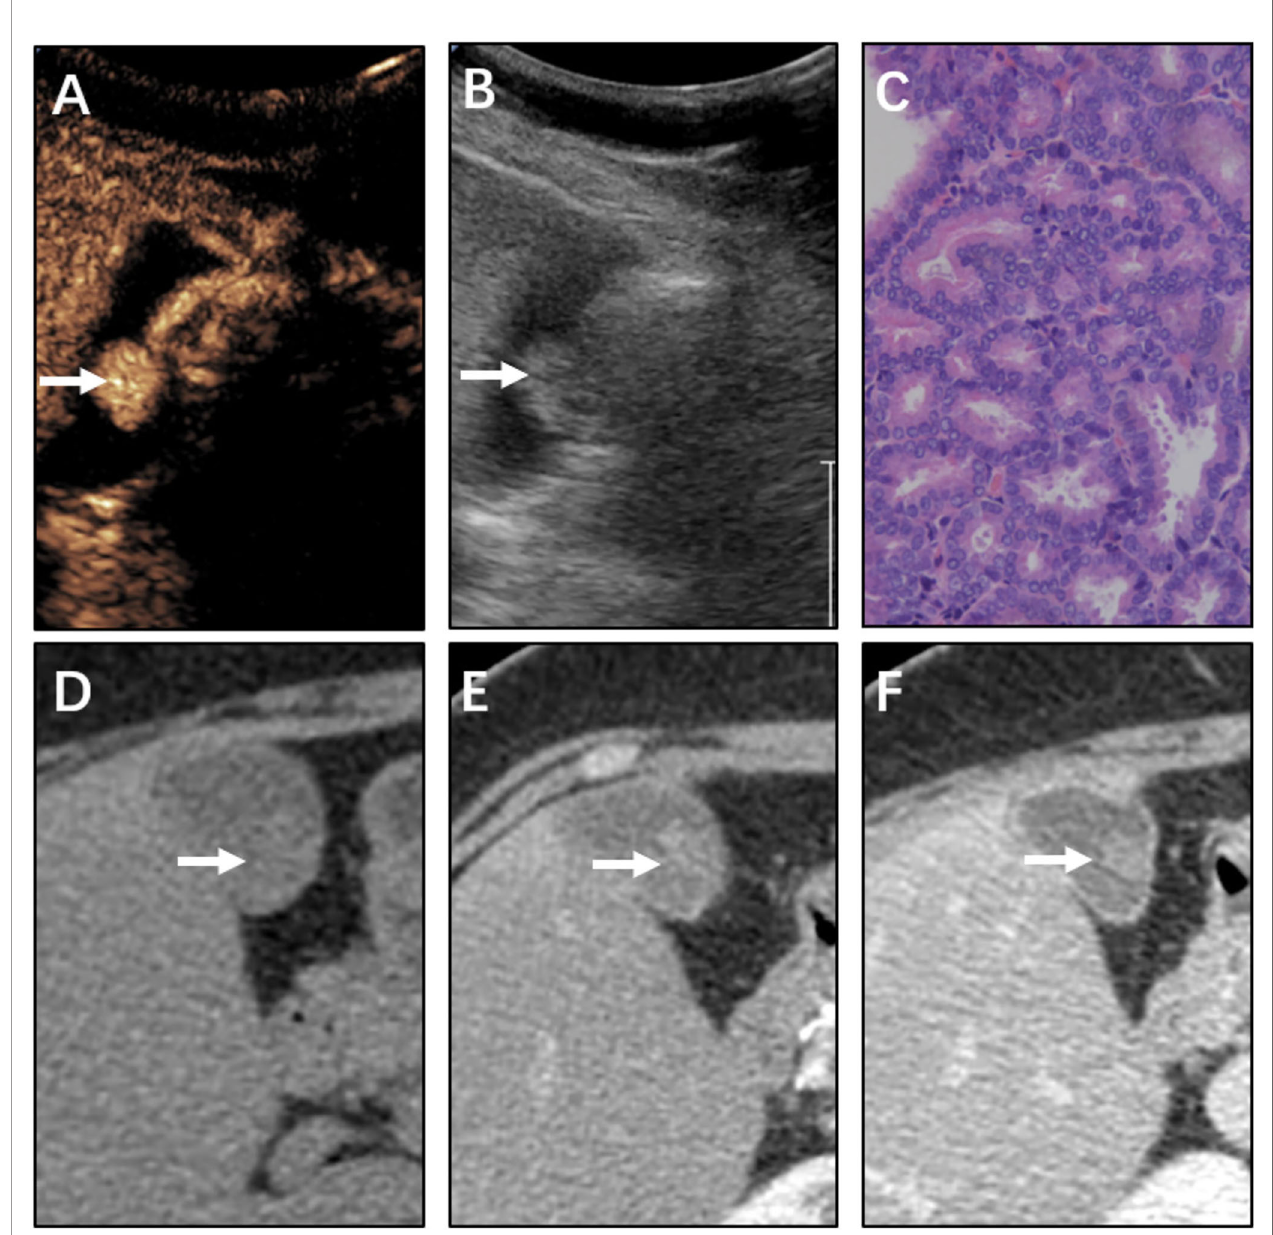
than that of adenocarcinoma in the arterial phase and portal venous